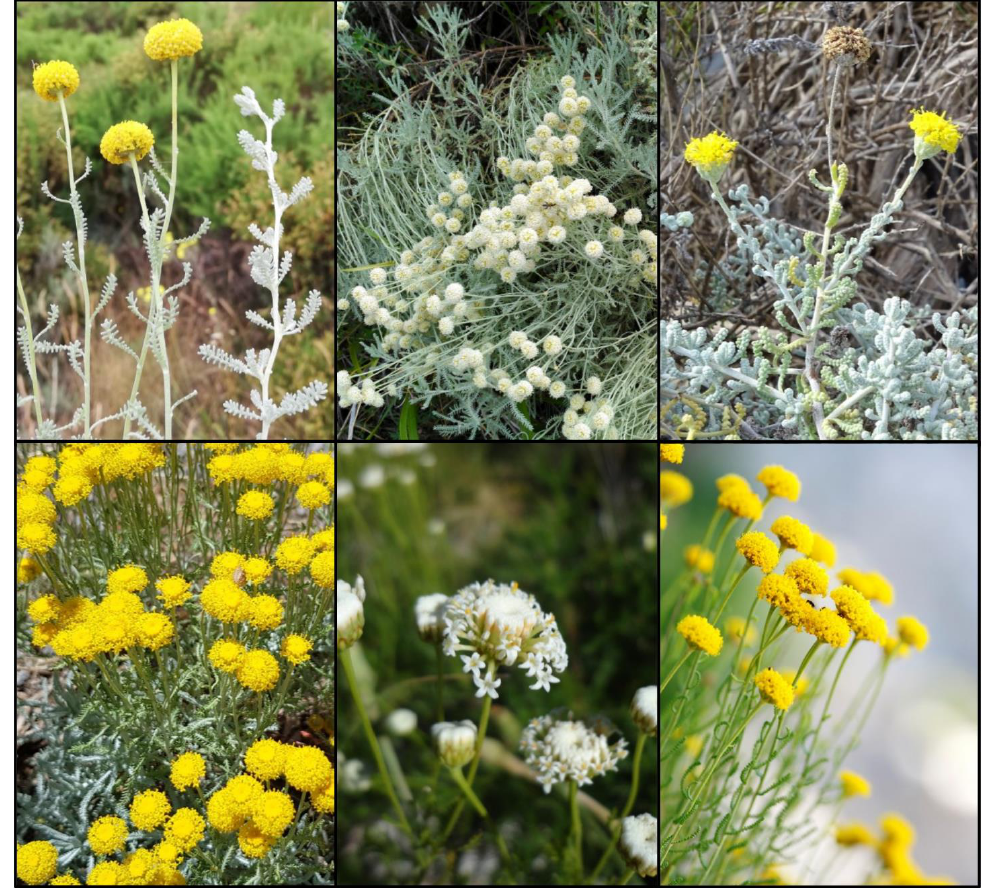
Figure 3. The pictures of the species of the S. chamaecyparissus complex. ( top ) From left to right: Santolina benthamiana (France, Occitanie, Prats-de-Mollo, photo by L. Peruzzi), S. chamaecyparissus (Italy, Tuscany, Orto e Museo Botanico di Pisa, photo by P. De Giorgi), S. corsica (Italy, Sardinia, Buggerru, photo by S. Cambria), S. decumbens s.str. (France, Provence-Alpes-C ô te d’Azur, Mont Caume, photo by L. Peruzzi), S. ericoides (Spain, Barcelona, Sant Feliu de Codines, photo by L. S á ez), and S. etrusca (Italy, Tuscany, Arcidosso, photo by L. Peruzzi). ( bottom ) From left to right: Santolina intricata (France, Occitanie, Le Roumenga, photo by L. Peruzzi), S. ligustica (Italy, Liguria, Deiva Marina, photo by G. Astuti), S. magonica (Spain, Mallorca, Cala Mesquida, photo by L. S á ez), S. neapolitana (Italy, Campania, Castellammare di Stabia, photo by P. Caputo), S. pinnata (Italy, Tuscany, Pian della Fioba (Apuan Alps), photo by L. Peruzzi), S. vedranensis (Spain, Es Vedr à (Balearic Islands), and photo by J. Serapio). Table 4. Identification key for all the taxa of the Santolina chamaecyparissus complex. Leaves of the non-flowering stems green, glabrous or scarcely pubescent 1a 2 (white-tomentose, at most, only on the central axis) Leaves of the non-flowering stems grey or white-tomentose, both on the central 1b 6 axis and on the leaf segments 2a Leaves of the non-flowering stems with segments >2 mm long 3 2b Leaves of the non-flowering stems with segments <2 mm long 4 3a Segments with acute apex. Flowers white S. pinnata Viv. 3b Segments with rounded apex. Flowers yellow S. benthamiana Jord. &